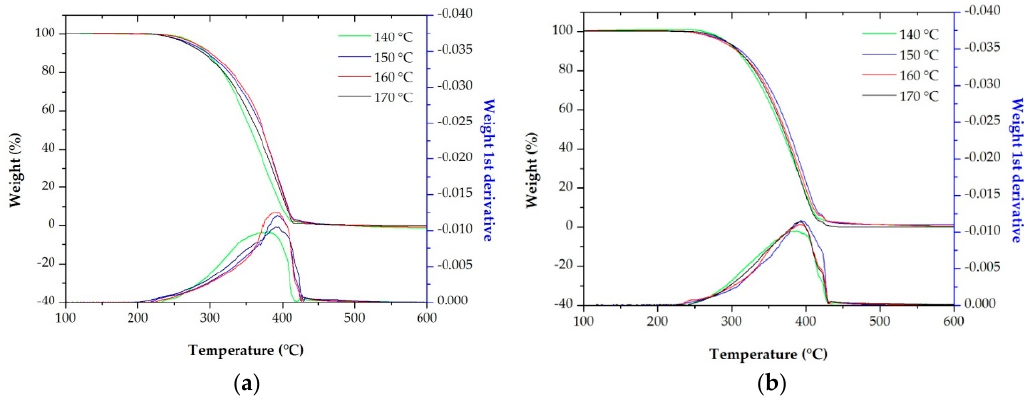
Figure 10. Thermogravimetric analysis ( TGA) and its respective first derivative (DTG) curves of samples ( a ) H-10R and ( b ) H-20B. Precursor films annealed at different temperatures and membranes prepared under the same stretching conditions.